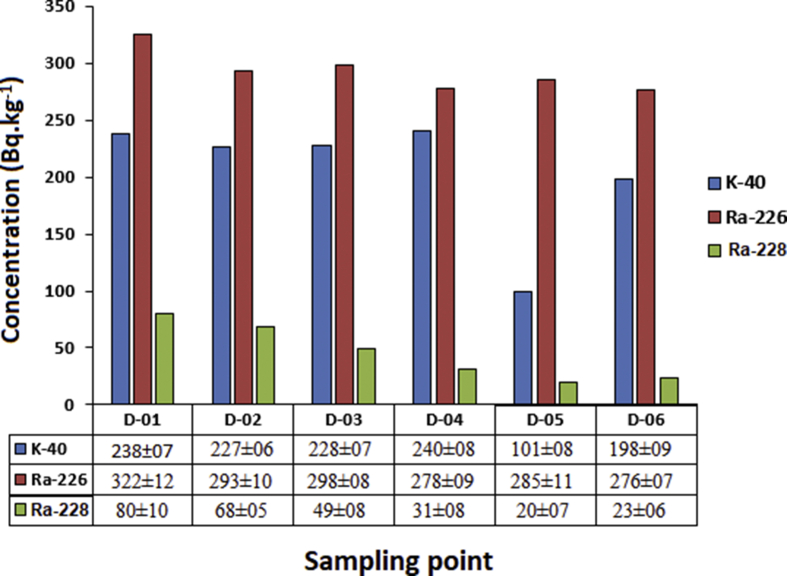
Concentration of 40K, 226Ra and 228Ra in soil samples irrigated by different sources of water.